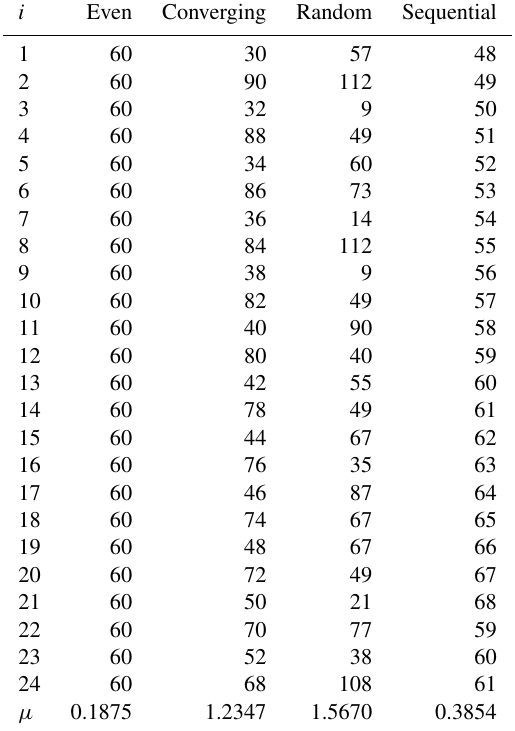
Table A1. Example of four time sequences (second to fifth columns) averaging 60min between consecutive events. Mutability values for each column are given in the last row. The first column lists the